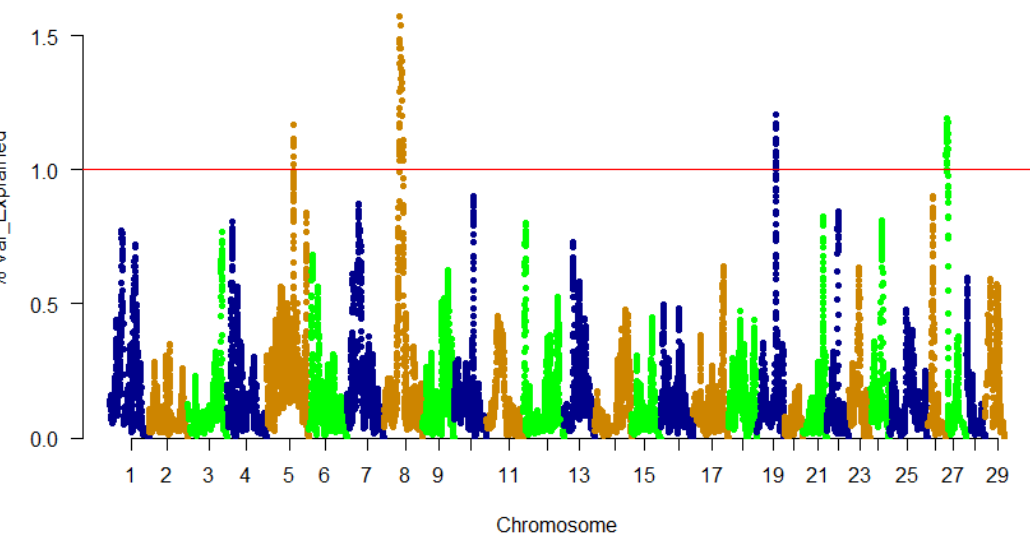
Figure 3. Manhattan plot of percent of genetic variance explained by 50 adjacent SNP windows for the fillet whiteness.